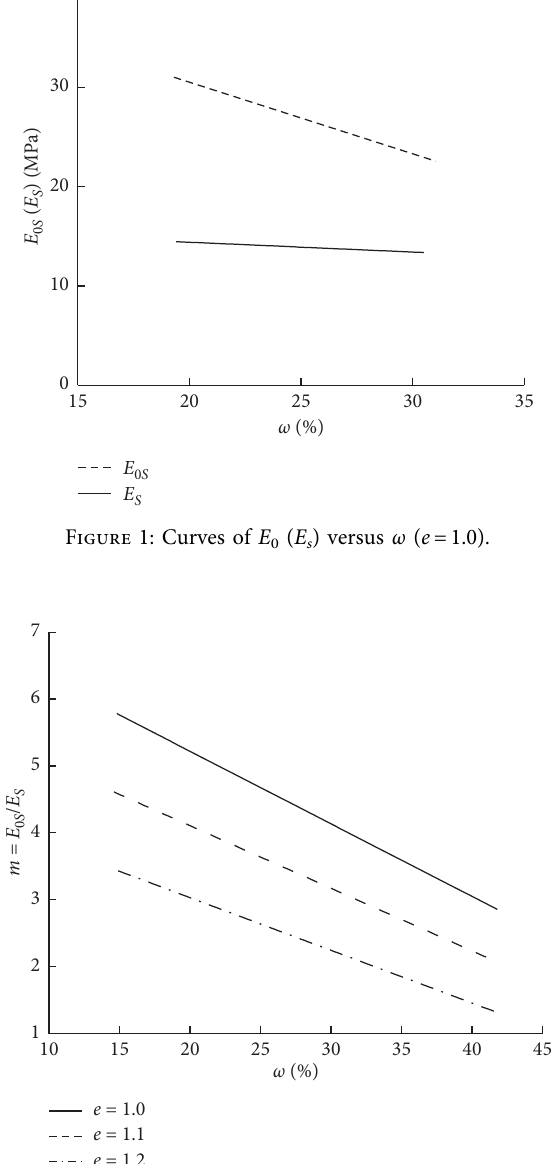
Figure 2: The relationship between m and ω under different e